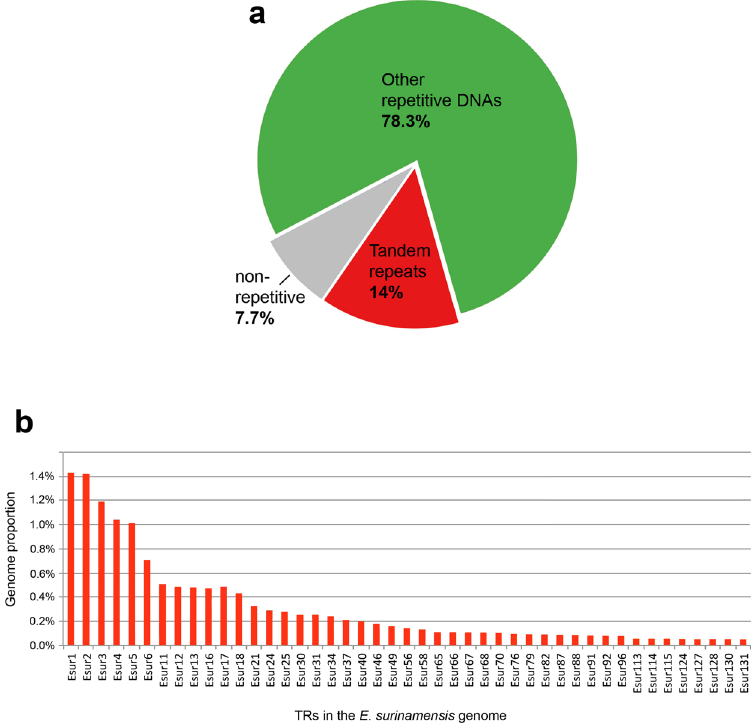
Figure 1. ( a ) Overview of the repetitive composition of E . surinamensis genome based on the output of RepeatExplorer. ( b ) Genomic proportion for each of the 45 satDNAs isolated and characterized. TRs, tandem